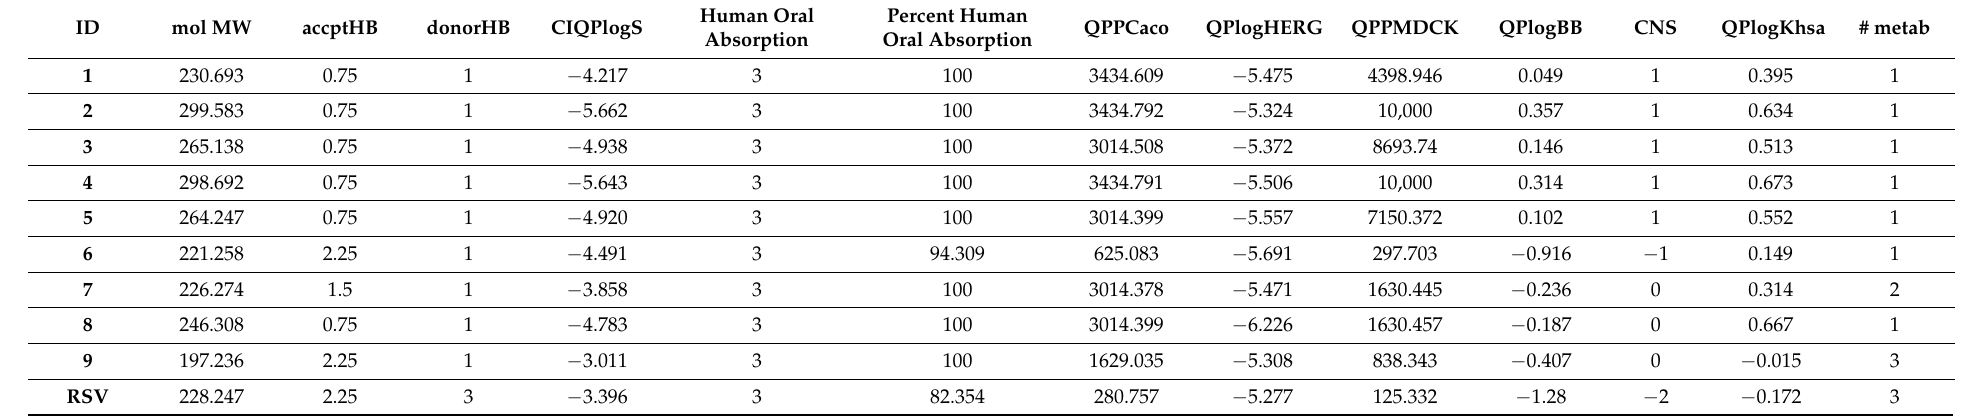
Table 5. Physicochemical and pharmacokinetic properties of the E -stilbenol